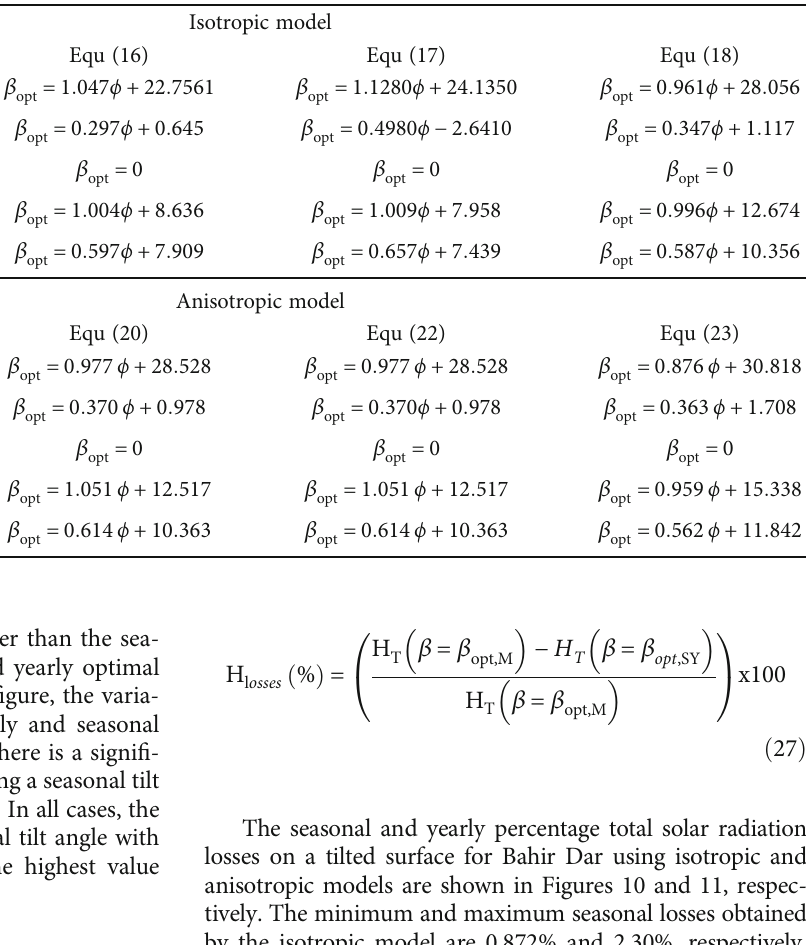
Figure 11: Solar radiation seasonal losses, annual losses relative to monthly and annual losses relative to seasonal Table 5: Developed isotropic and anisotropic seasonal and annual optimal tilt angle models.